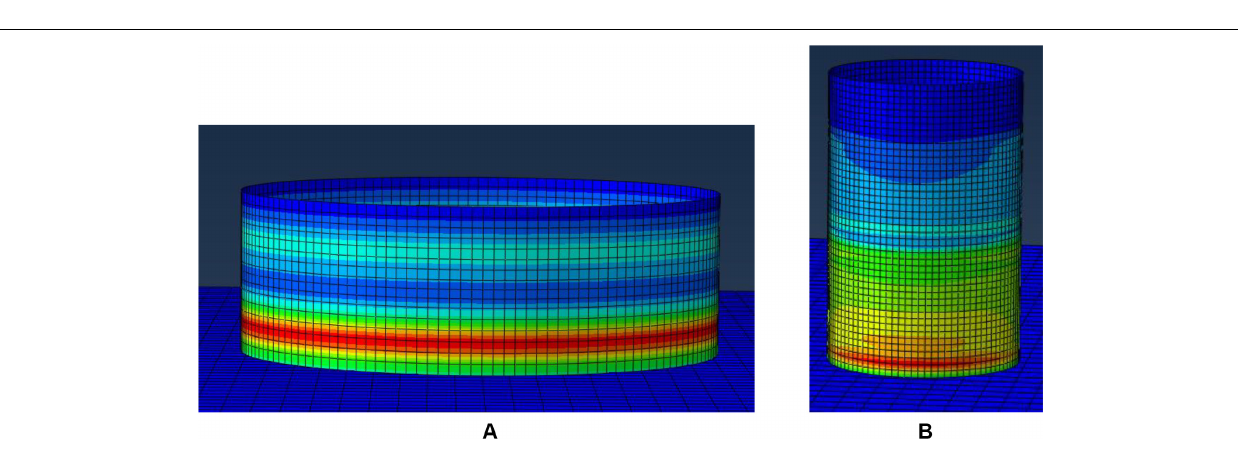
Frontiers in Built Environment |